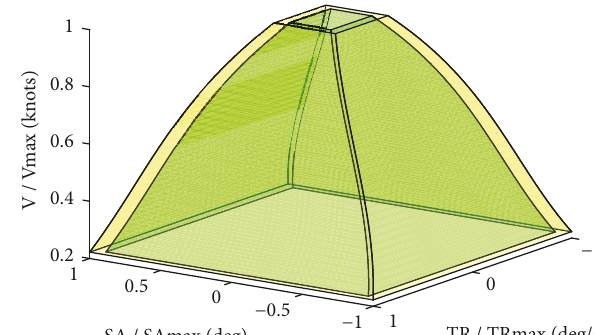
Figure 3: The relationship of safe space, green space, and buffer space.